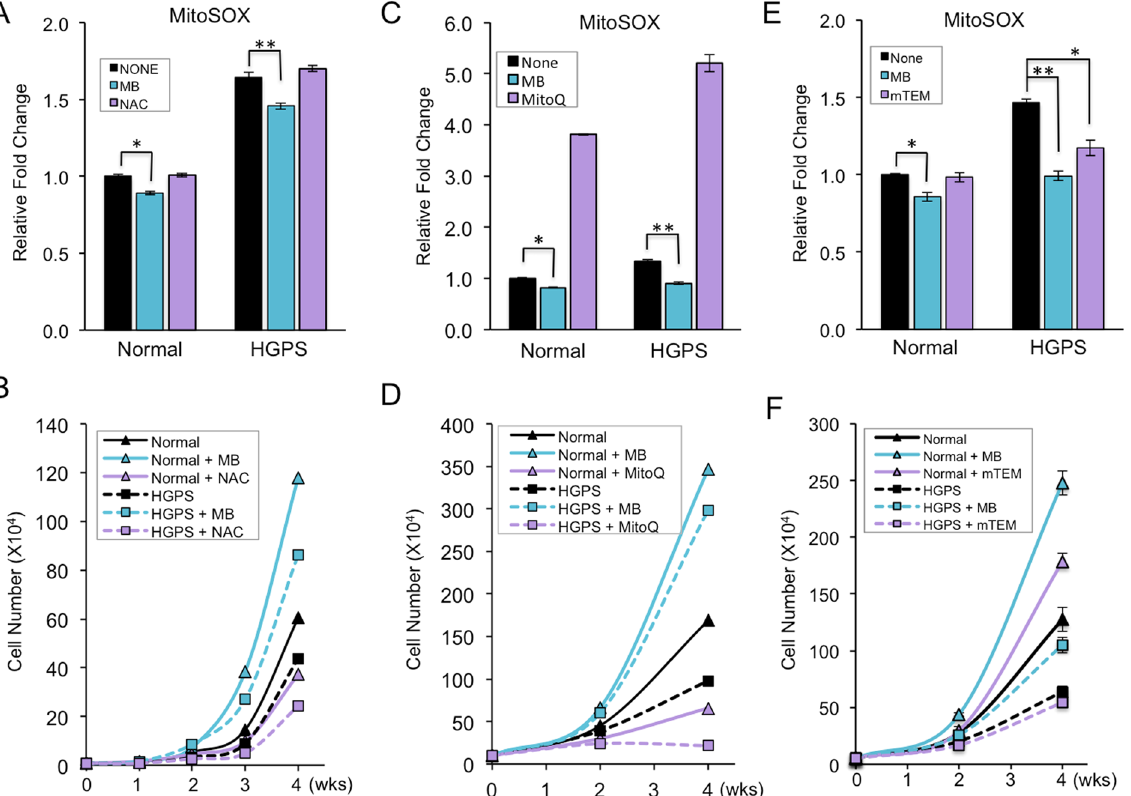
Figure 1. MB is a more potent ROS scavenger than NAC, MitoQ and mTEM. ( A ) Comparison of mitochondrial specific superoxide (MitoSOX) levels in normal and HGPS fibroblasts treated with vehicle, 100 nM MB or 100 μ M NAC for four weeks. ( B ) Growth curves of normal and HGPS fibroblasts during the four-week treatment with vehicle, 100 nM MB or 100 μ M NAC. ( C ) Comparison of MitoSox levels in normal and HGPS fibroblasts treated with vehicle, 100 nM MB or 100 nM MitoQ for four weeks. ( D ) Growth curves of normal and HGPS fibroblasts during the four-week treatment with vehicle, 100 nM MB or 100 nM MitoQ. ( E ) Comparison of MitoSox levels in normal and HGPS fibroblasts treated with vehicle, 100 nM MB or 100 nM mTEM for four weeks. ( F ) Growth curves of normal and HGPS fibroblasts during the four-week treatment with vehicle, 100 nM MB or 100 nM mTEM. ( * p < 0.05, ** p <